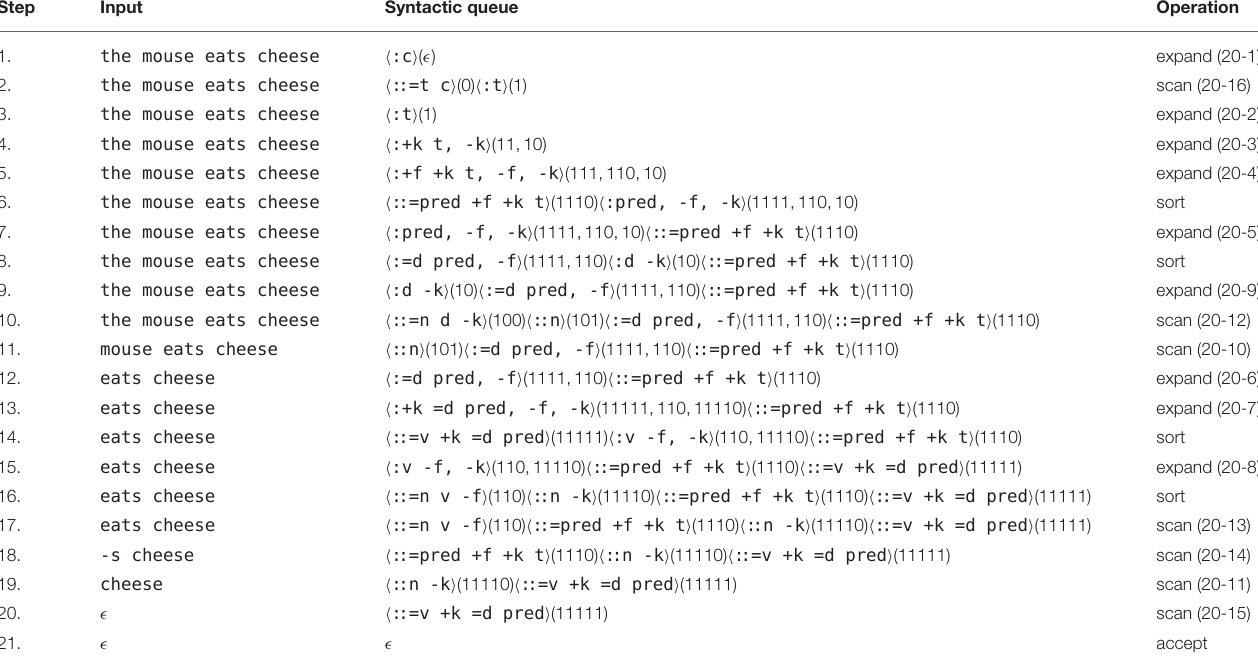
TABLE 3 | MG top-down parse of the mouse eats cheese .